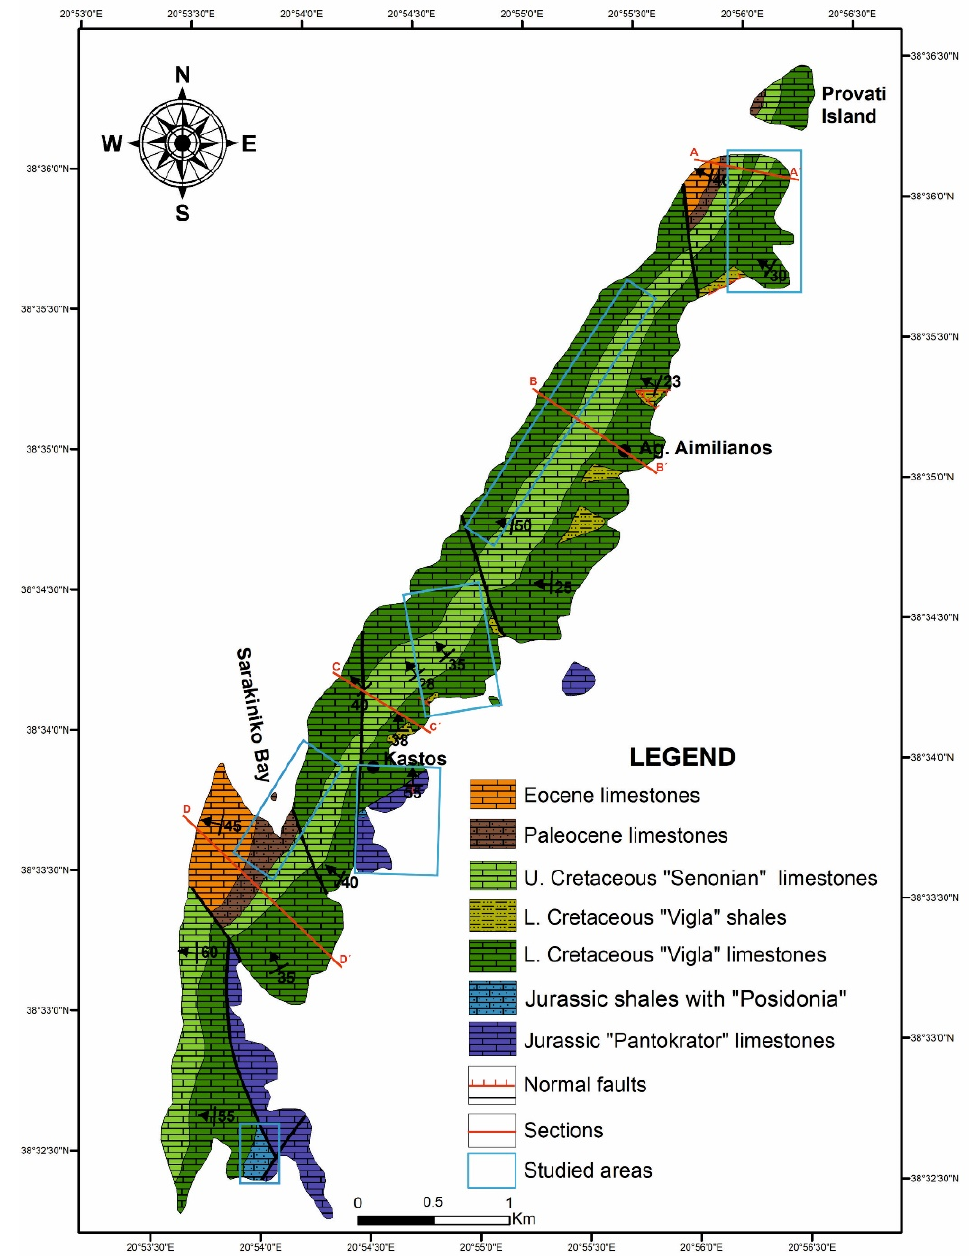
Figure 8. The final improved version of Kastos Island geological map. Note the absence of Paleocene and Eocene deposits in the center of the western side of the island. Cross-sections correspond to Figure 9, whereas blue boxes show the detailed studied areas with the selected samples.